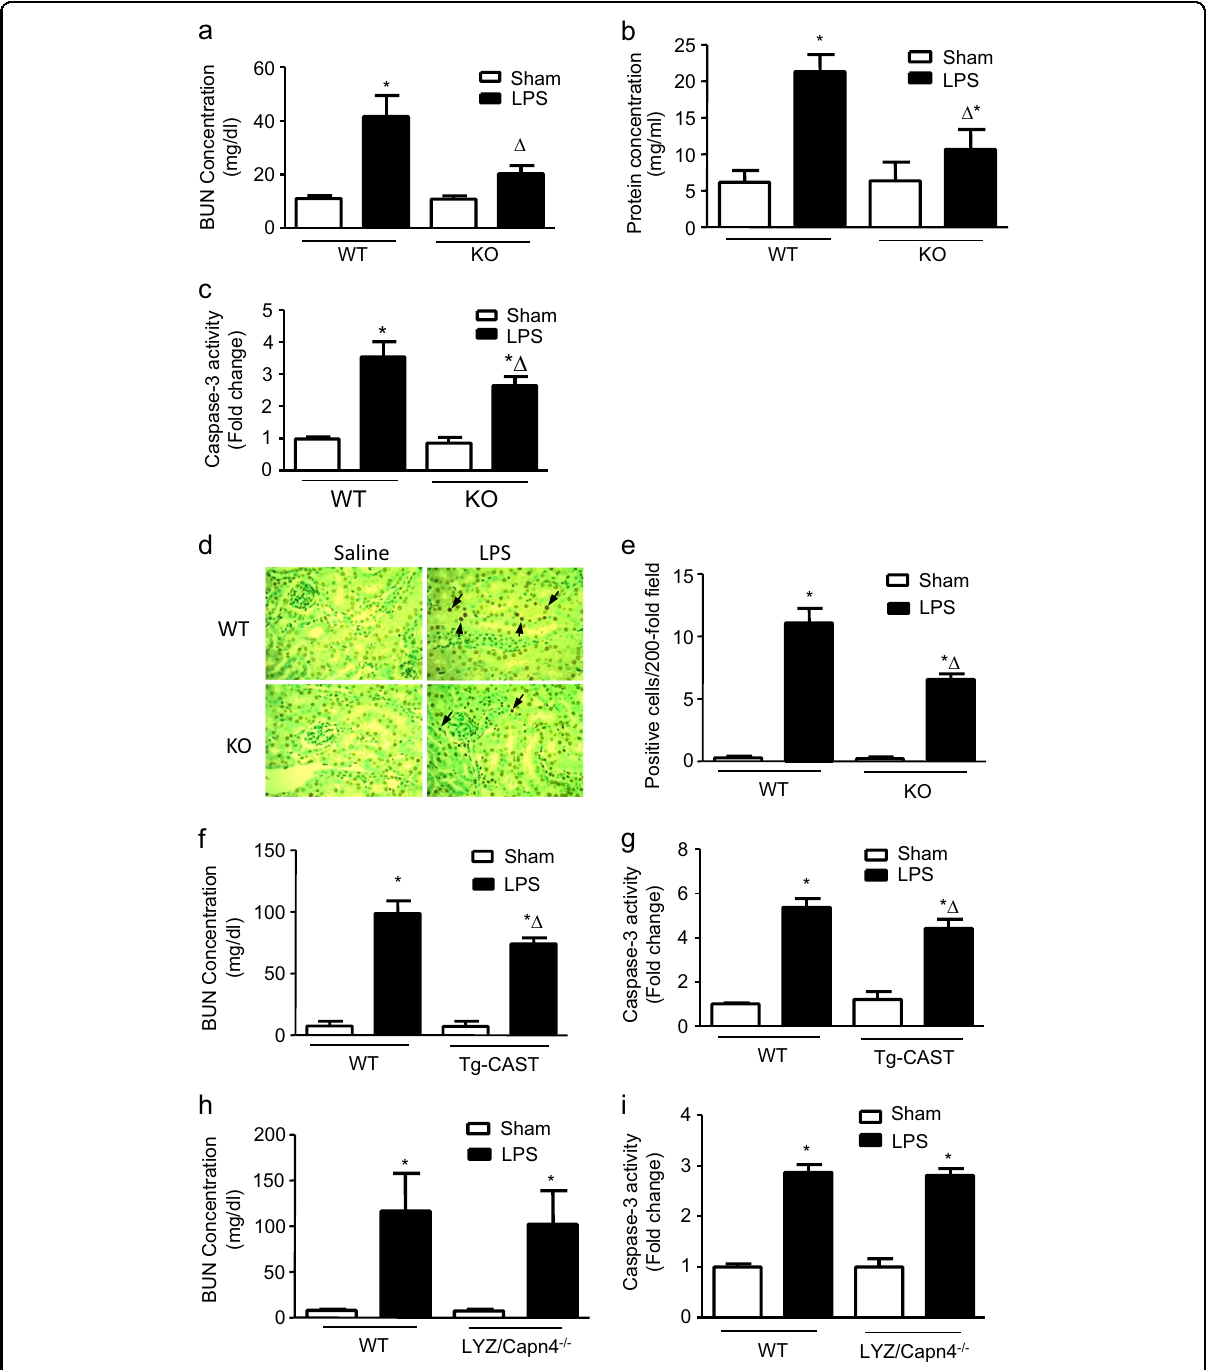
Fig. 1 Role of endothelial-speci fi c Capn4 knockout in LPS-induced kidney injury. Wild-type (WT) and endothelial-speci fi c Capn4 knockout (KO) mice were stimulated with LPS (i.p., 4 mg/kg) for 18 h. The plasma BUN concentration ( a ), urinary protein levels ( b ), and renal caspase-3 activity ( c ), and TUNEL staining ( d ; the arrows show apoptotic cells) were assessed. Quantitative results of the number of TUNEL-positive cells per ×200 magni fi cation fi eld in kidney tissues are shown ( e ). In addition, mice with calpastatin overexpression (Tg-CAST) and myeloid-speci fi c Capn4 knockout (LYZ/Capn4 − / − ) were also treated with LPS, and changes in kidney injury were assessed. BUN concentrations in plasma ( f and h ) and caspase-3 activity ( g and i ) in kidney tissue were detected. * P < 0.05 vs. the WT Sham group; Δ P < 0.05 vs. the WT LPS group, n = 6 –